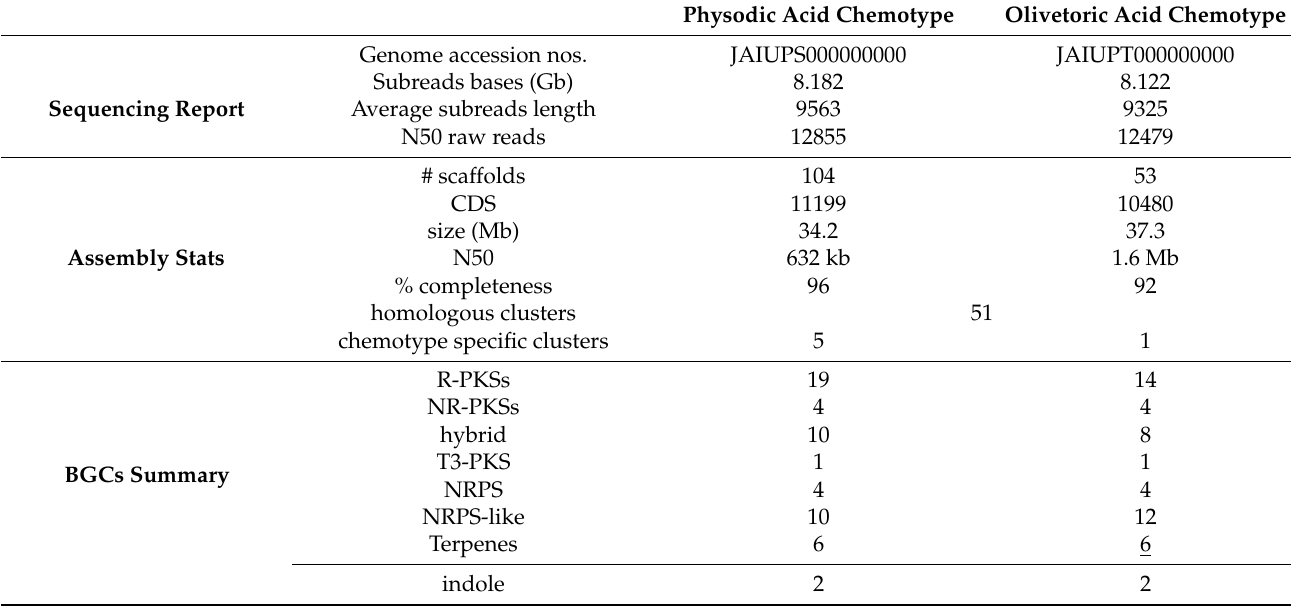
Table 1. Genome statistics and GB accession numbers of the two chemotypes of P. furfuracea